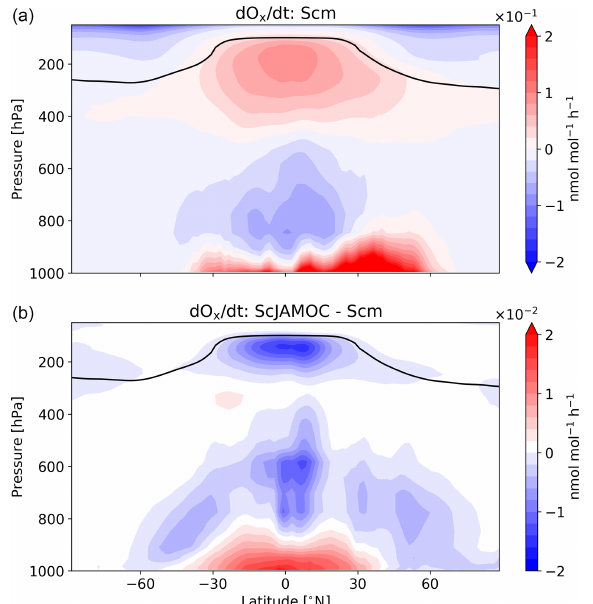
Figure 8. Mean zonal net O x change for Scm (a) and in compar- ison to ScJAMOC (b) . The characteristics of each simulation are provided in Table 1. The yearly mean tropopause is depicted by a black line. Deposition in the lowest model layer is not taken into account.